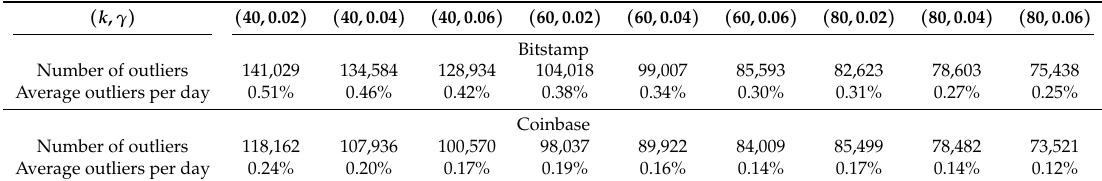
Table 1. Number of outliers and average number of outliers per day in percentage points as a function of the rolling trimmed mean parameter k and the granularity parameter γ . Results are reported for Coinbase and Bitstamp using Equation (1) with δ =